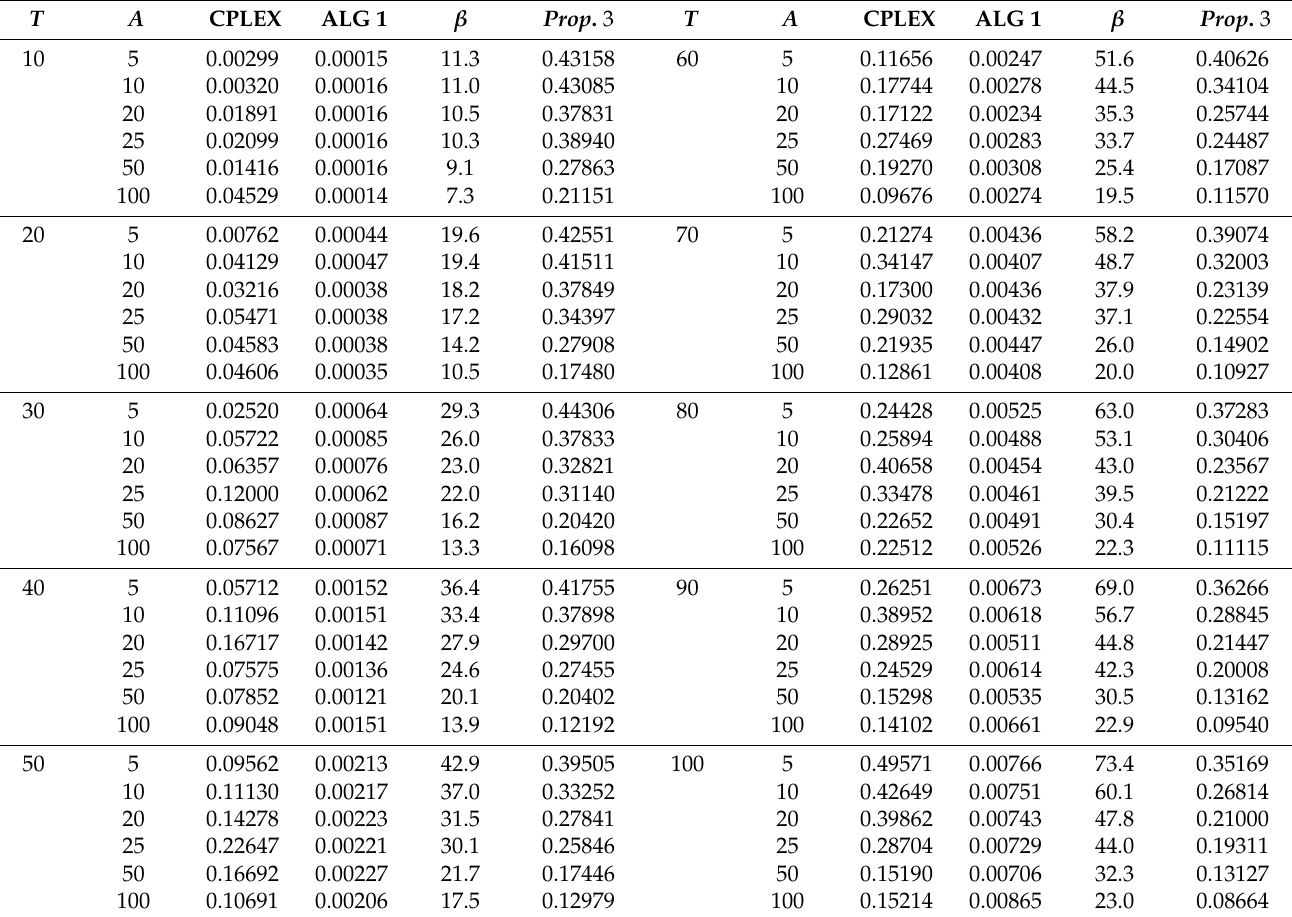
Table 5. Output data of the computational